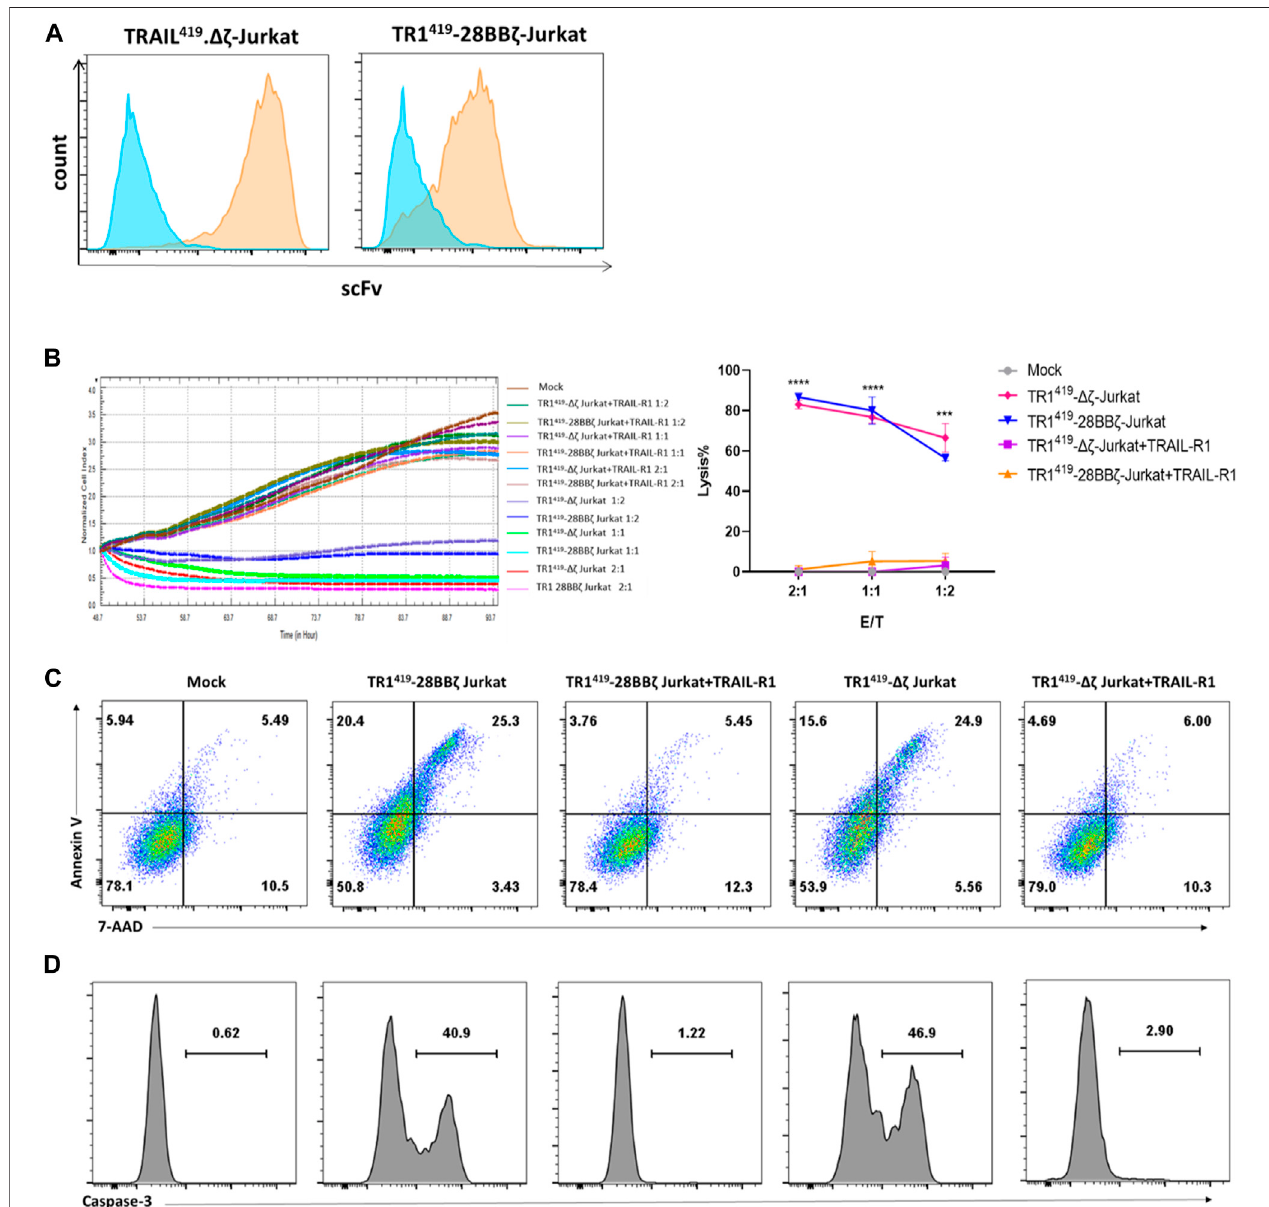
FIGURE 3 | scFv from TR1 419 CAR-mediated tumor cell apoptosis by binding with TRAIL-R1. (A) The expressions of TR1 419 -28BB ζ in Jurkat cells were detected by fl ow cytometry. (B) Cytotoxicity of TR1 419 -28BB ζ - and TR1 419 Δζ -Jurkat cells against SW480 in the absence or in the presence of soluble TRAIL-R1 protein was determined by RTCA. (C) SW480 cocultured with TR1 419 -28BB ζ -and TR1 419 Δζ -Jurkat cells for 2 h before subjected for FACS to identify apoptotic cell populations (Annexin V+/7-AAD − and Annexin V+/7-AAD+). (D) The expression of caspase-3 in SW480 was analyzed by fl ow cytometry, after incubation with effector cells